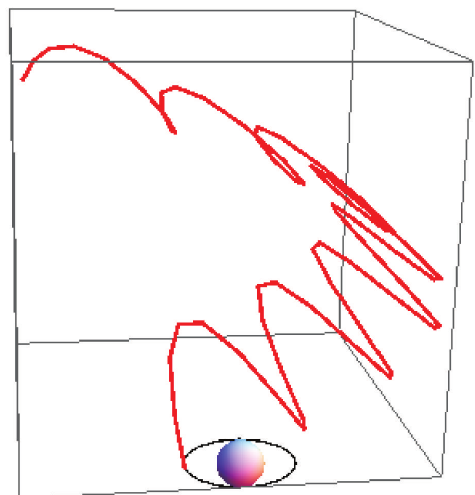
Figure 14: Trajectory of the escaping particle around RN-BH, for 𝑏 = 0.5 , ℓ = 1 , E = 1 , 𝜌[0] = 0.51 .